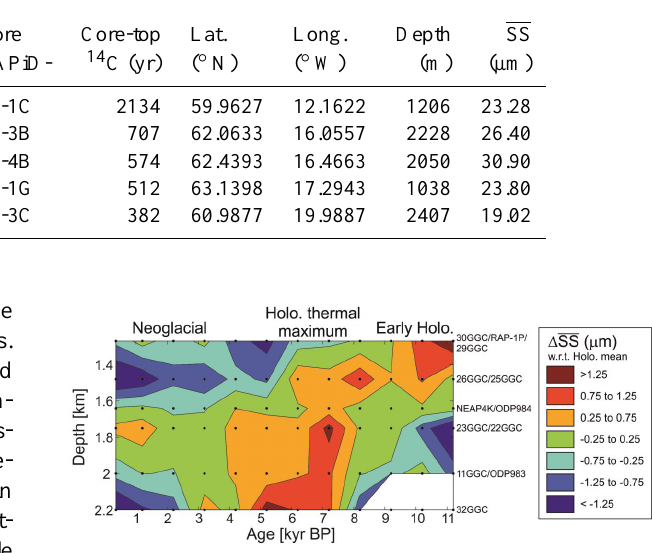
Fig. 4. Contour plot showing Holocene changes in SS (i.e. inferred 4 flow speed) across the depth transect of cores. There is a progressive shift in the timing of the inferred flow speed maxima with increasing water depth (i.e. deeper sites peak